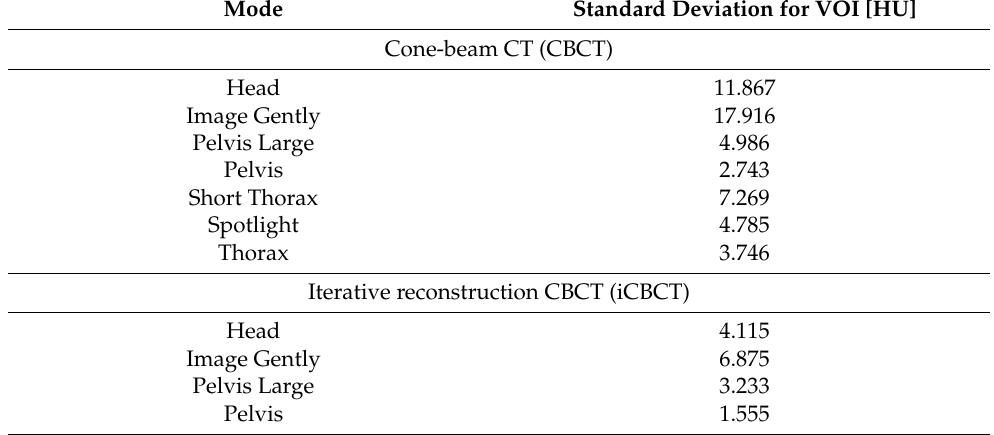
Table 4. Impact of reconstruction algorithms and modes on image uniformity for scanning PABIG nx in PH-5-DD1 GeVero Co. container with the TrueBeam accelerator equipped with CBCT and iCBCT. VOI: 20 mm diameter, 20 mm